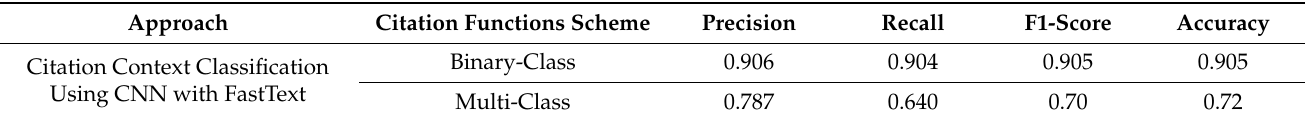
Precision, recall, f1-score, and the accuracy results for citation context classification using binary and multiclass schemes.